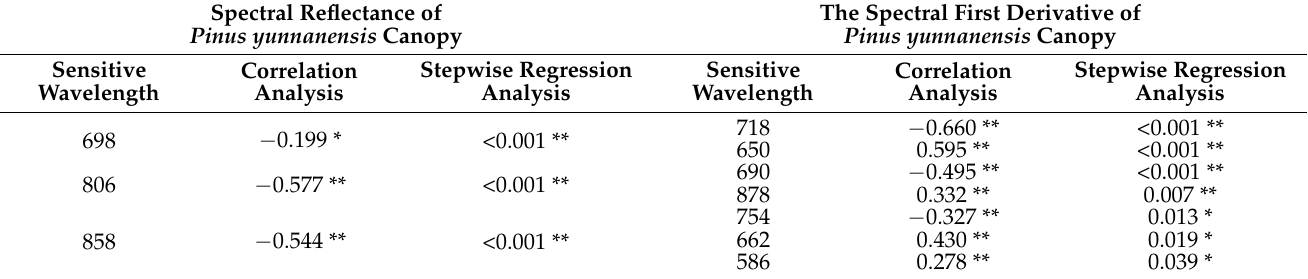
Figure S3. Correlation analysis between different damage degrees by Tomicus and the spectral pa- rameter of Pinus yunnanensis canopy (( a ). the spectral reflectance ( b ). the first derivative of spectra).